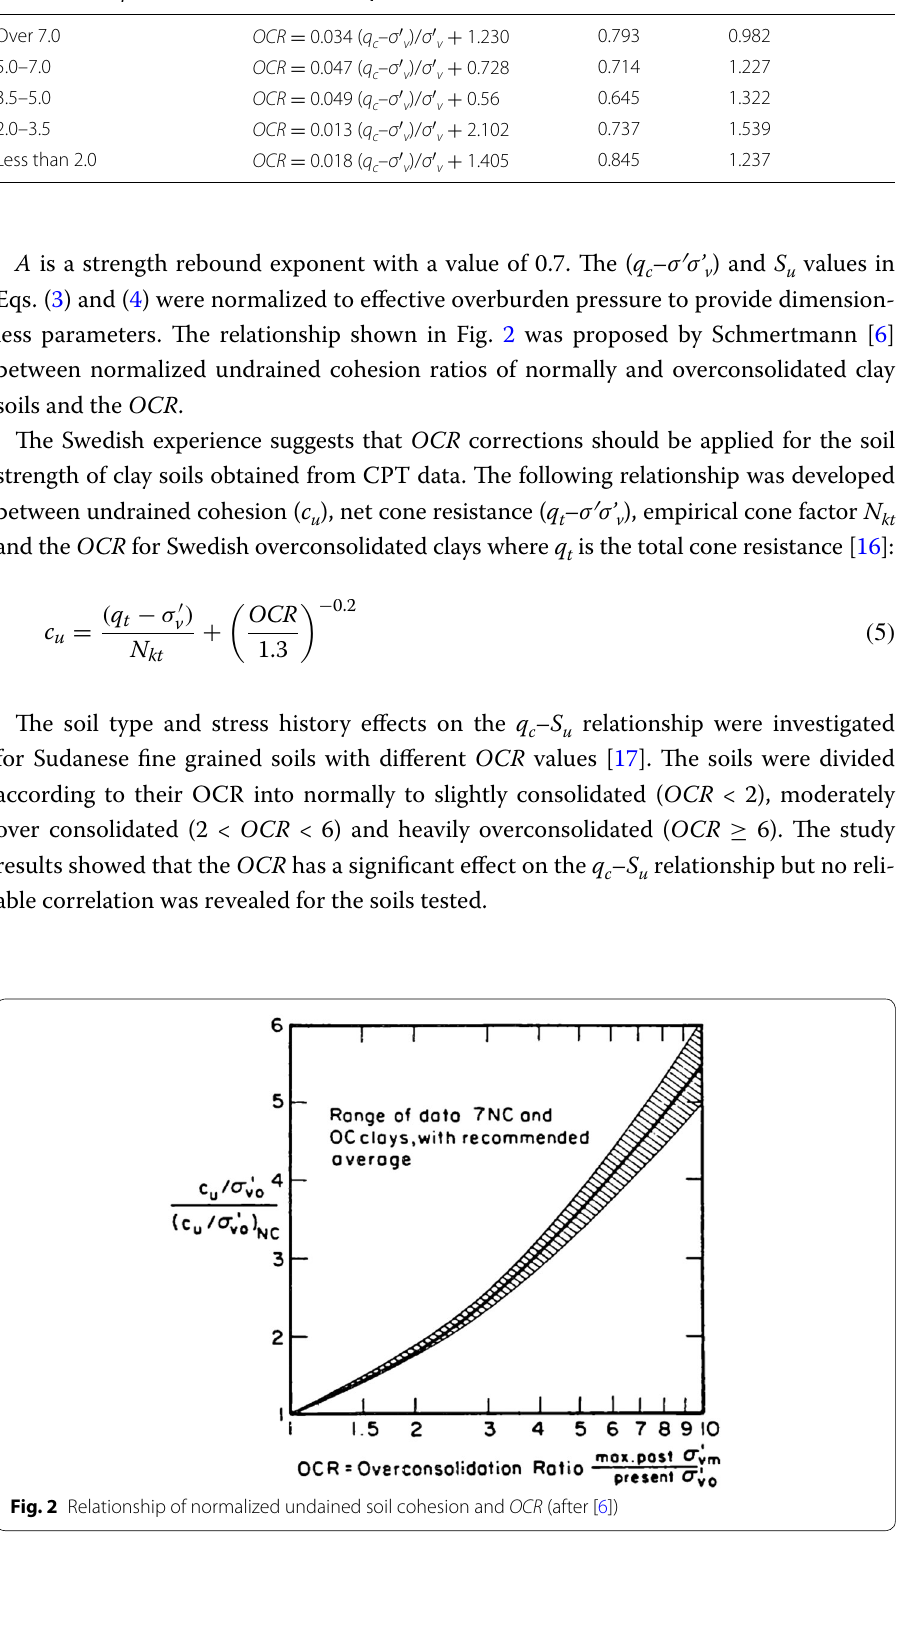
Table 2 Prediction of the OCR of fine grained soils from CPT cone resistance Friction ratio R f (%) Best fit line equation R 2 Standard deviation Over 7.0